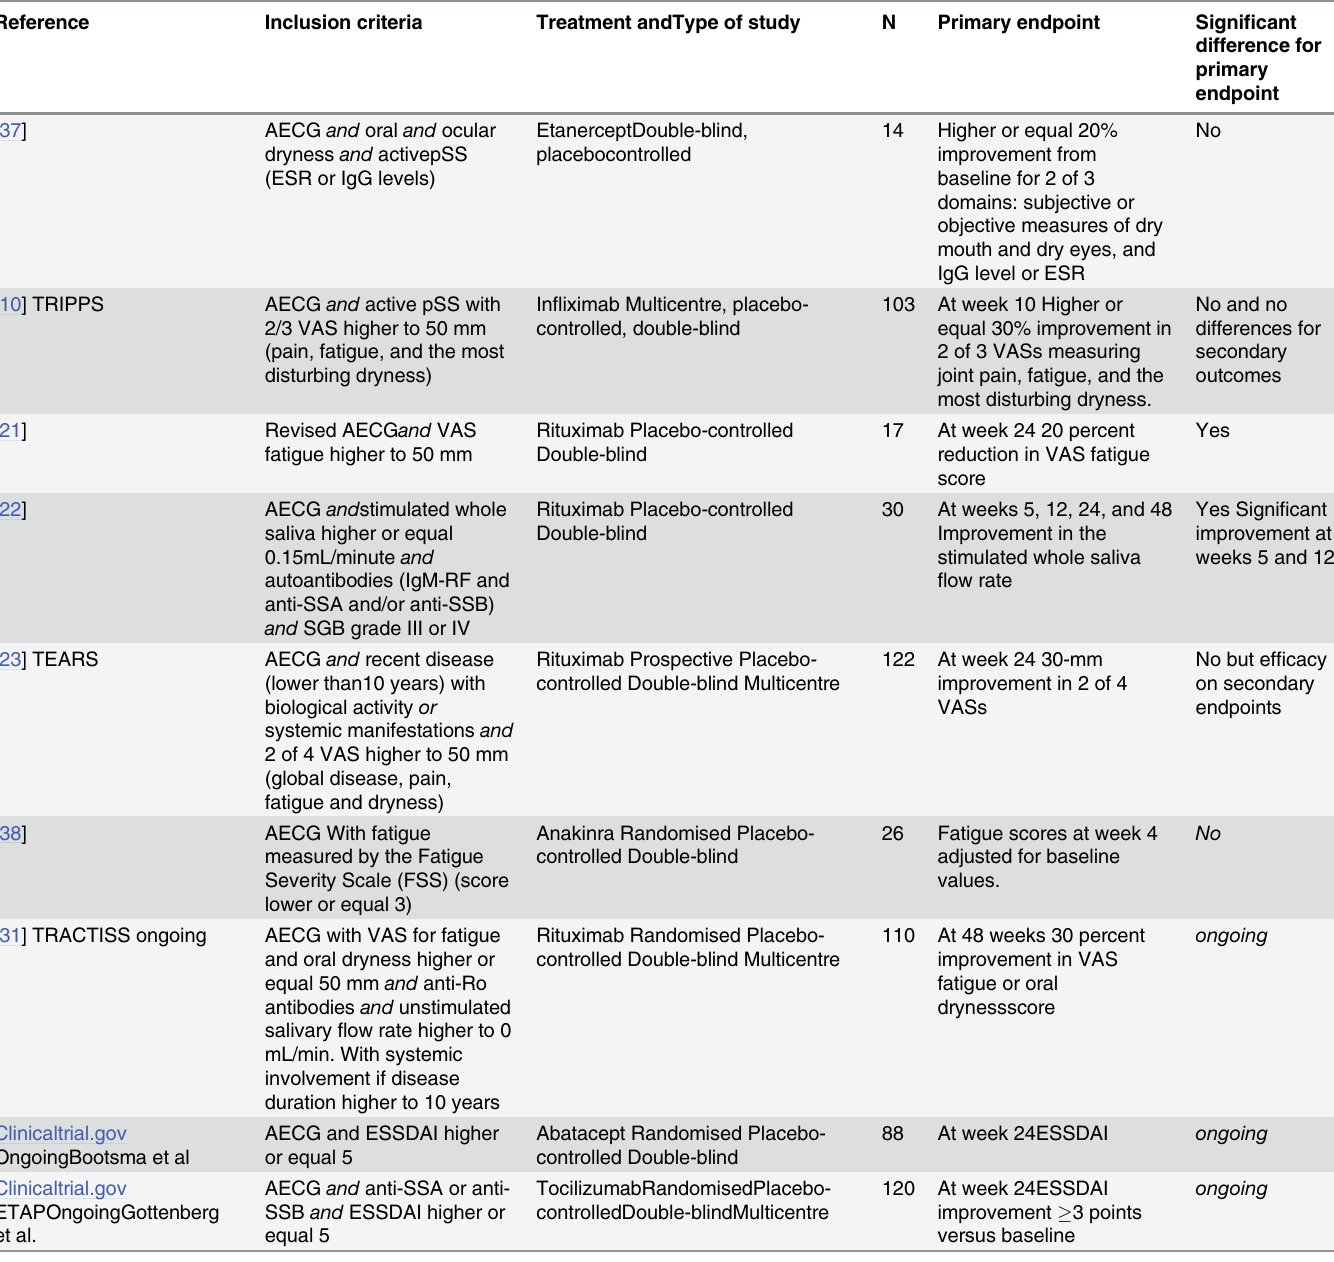
Table 2. Controlled therapeutic trials of biologics in primary Sjögren ’ s syndrome reported between 2002 and